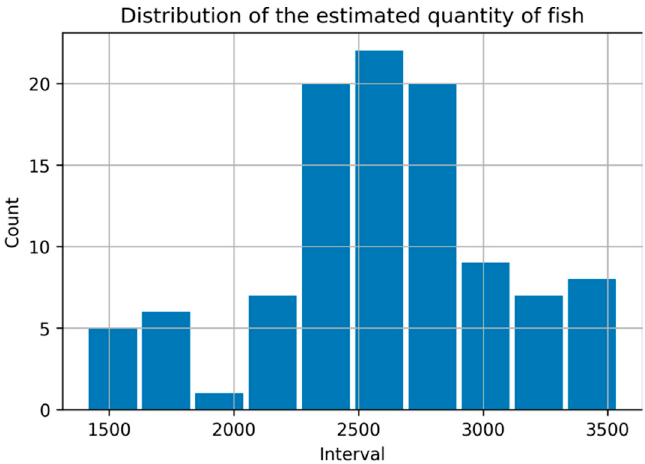
Figure 25. The distribution of the estimated fish quantity.